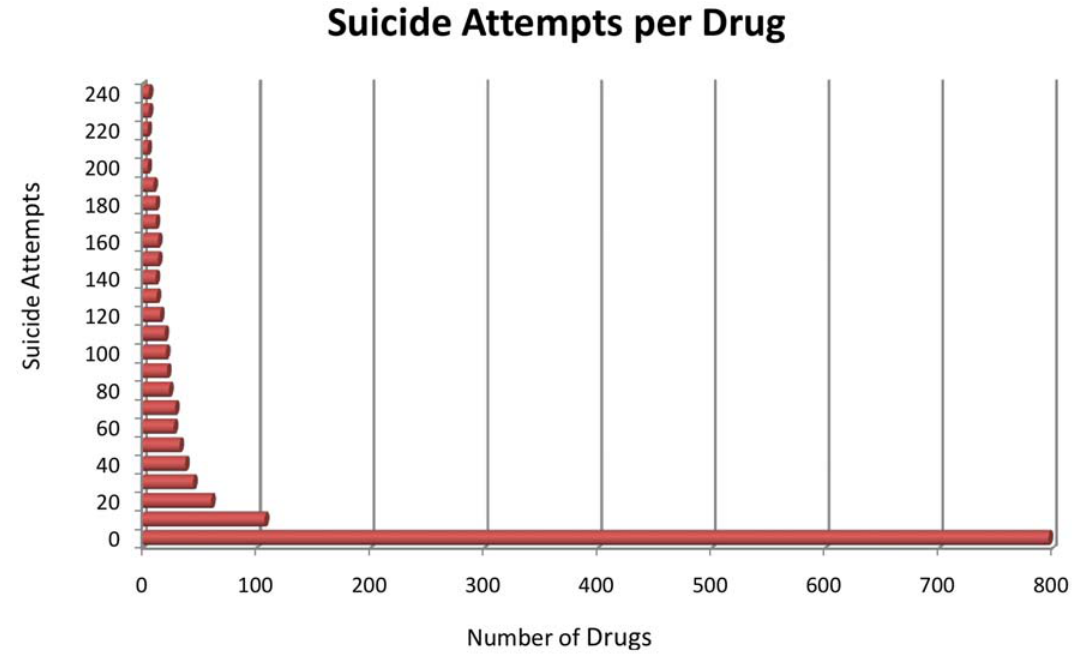
Figure 2. Distribution of suicide attempts per drug.